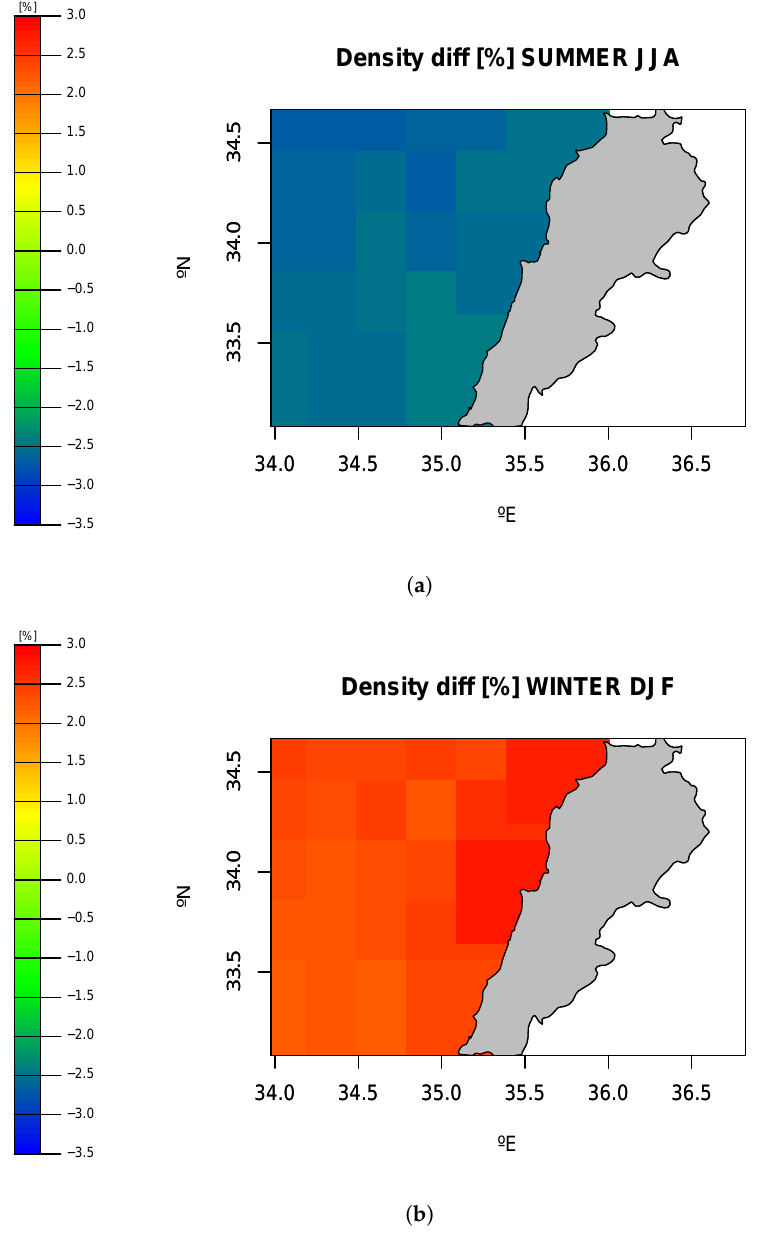
Figure 4. Seasonal air density differences of ¯ ρ [%] with respect to ρ 0 = 1.19 kg/m 3 . ( a ) Summer. ( b )